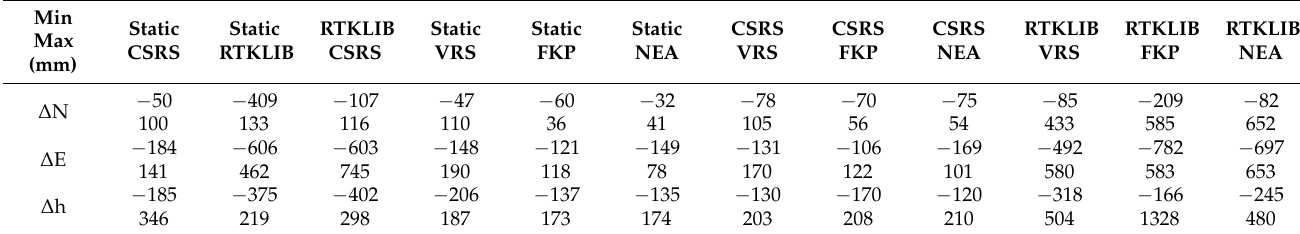
Table 1. Range of variability of the coordinate differences (min – max in